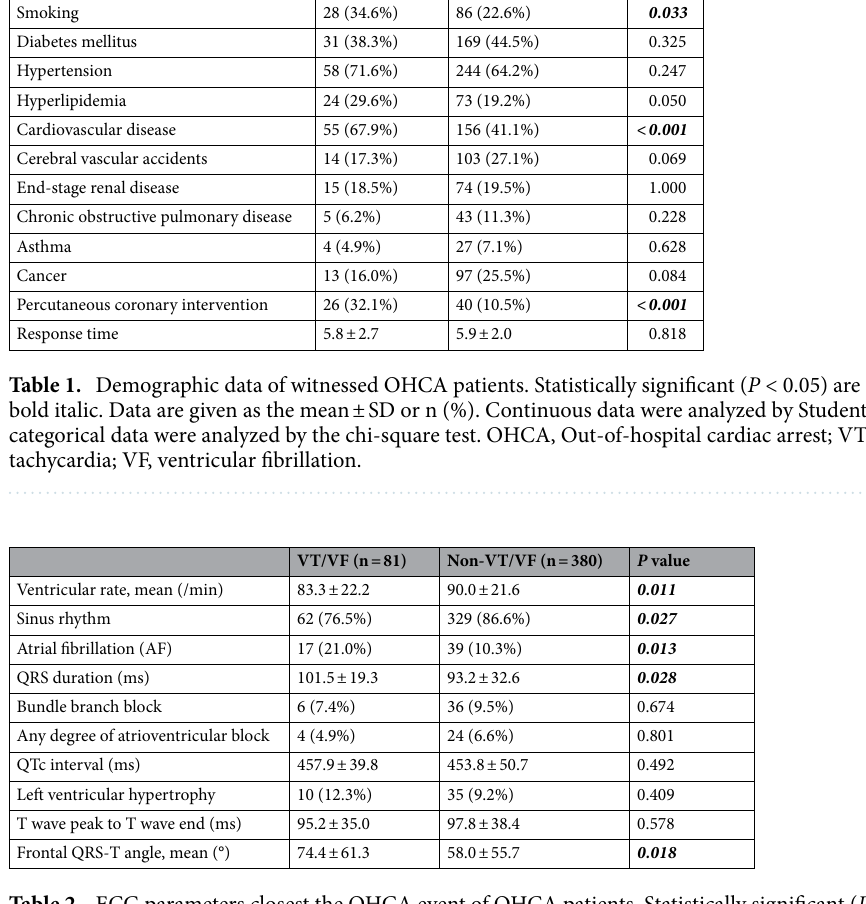
Table 2. ECG parameters closest the OHCA event of OHCA patients. Statistically significant ( P < 0.05) are given in bold italic. Data are given as the mean ± SD or n (%). Continuous data were analyzed by Student’s t test, and categorical data were analyzed by the chi-square test. OHCA, Out-of-hospital cardiac arrest; VT, ventricular tachycardia; VF, ventricular